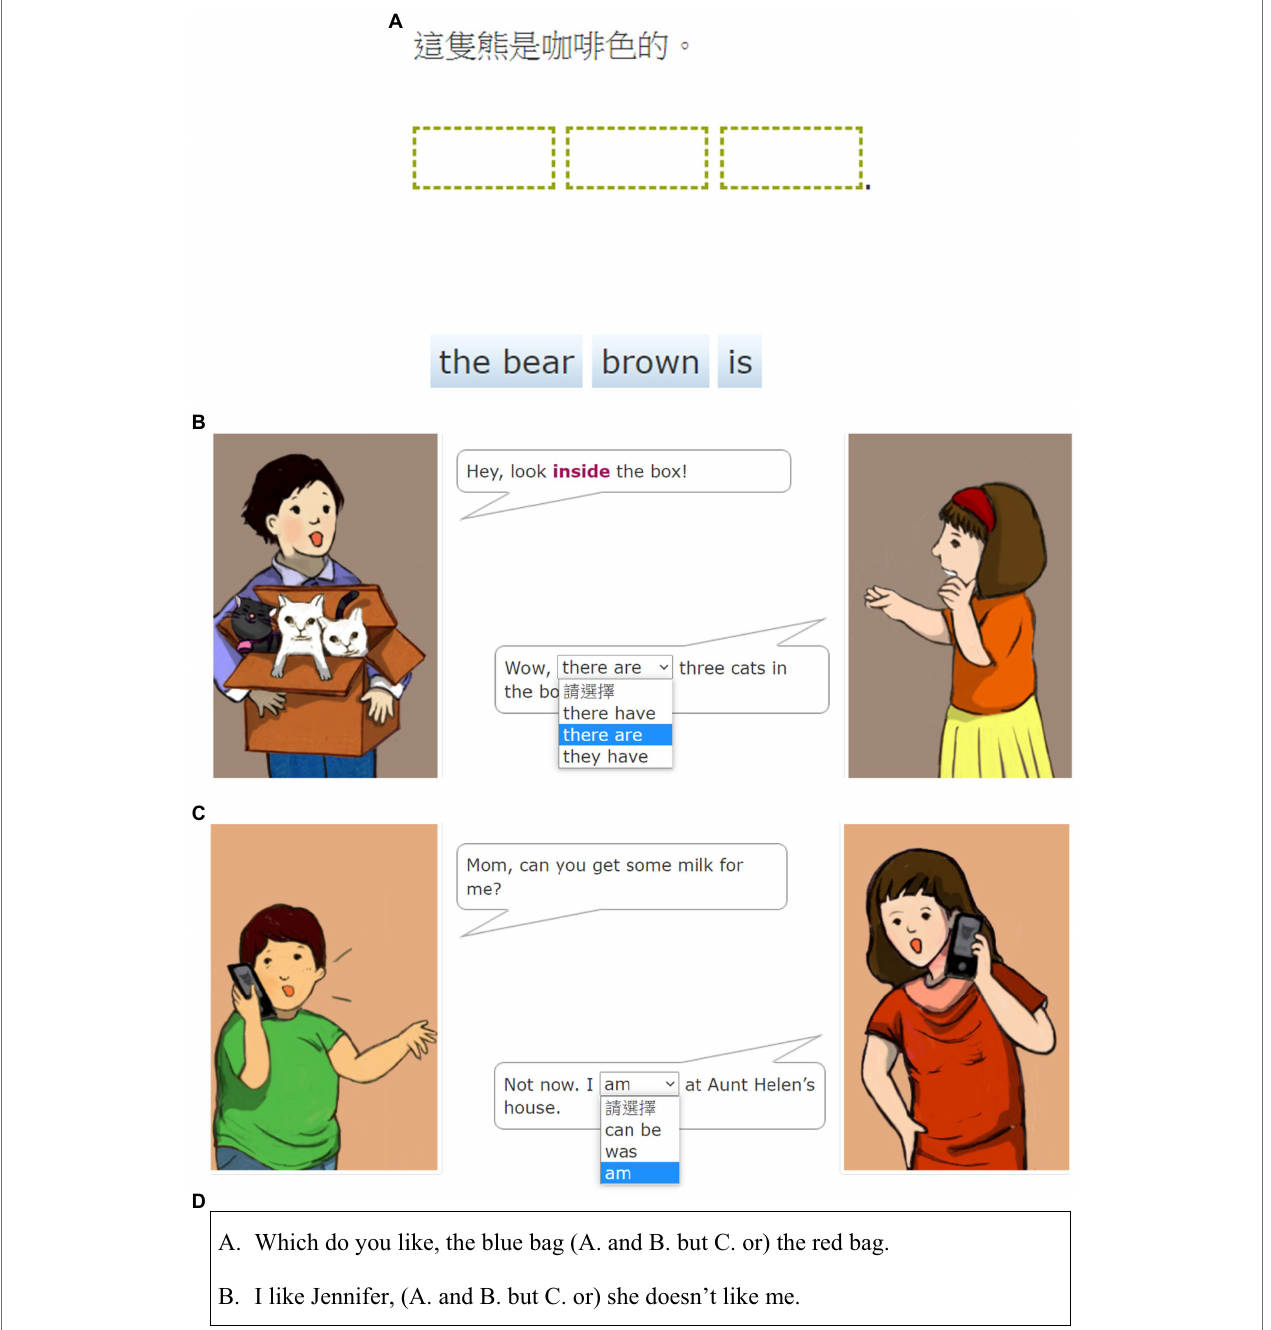
FIGURE 1 | (A) An example of a GF question. (B) An example of a GF question. (C) An example of a GM question. (D) An example of a GM